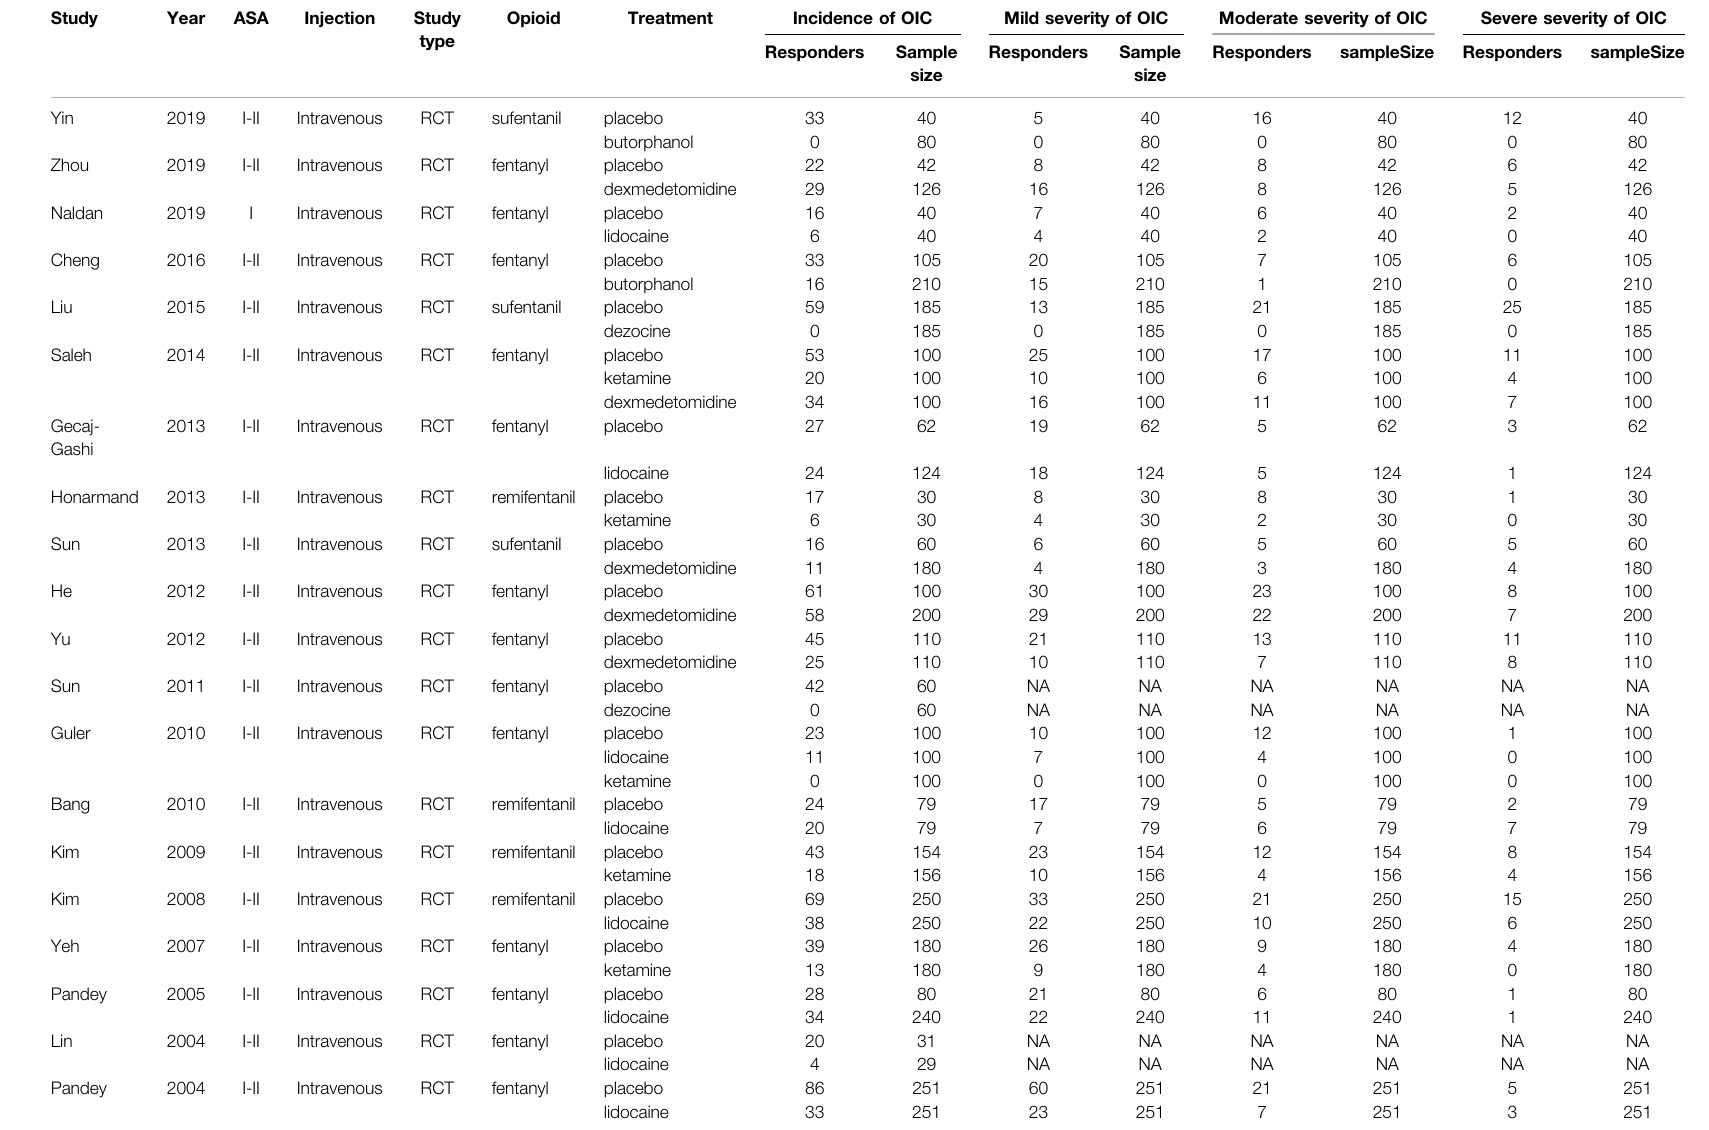
TABLE 1 | Detailed information of individual studies enrolled in this network meta-analysis.